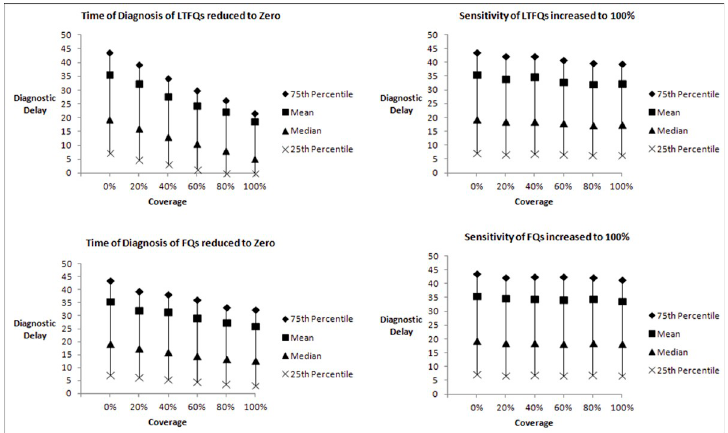
Fig 2. Effect of reduced time to diagnosis and increased diagnostic accuracy: Mumbai. Distribution of 10,000 simulations where time to diagnosis was minimized, and diagnostic accuracy (sensitivity) was maximized, for less- than-fully-qualified providers (LTFQs) and fully qualified providers (FQ). Coverage is the proportion of providers for whom the parameter specified was manipulated.